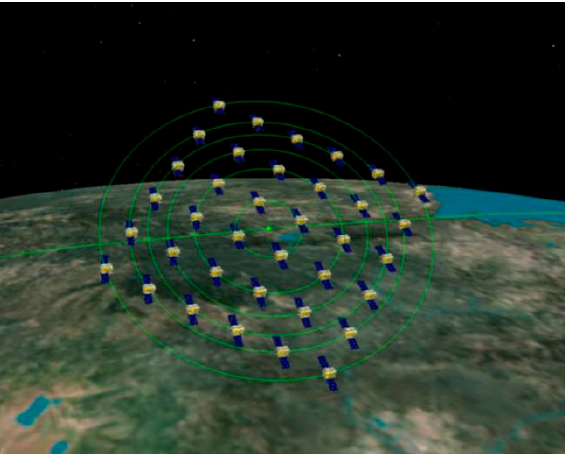
Figure 4. Distributed satellite constellation configuration generated by STK software.